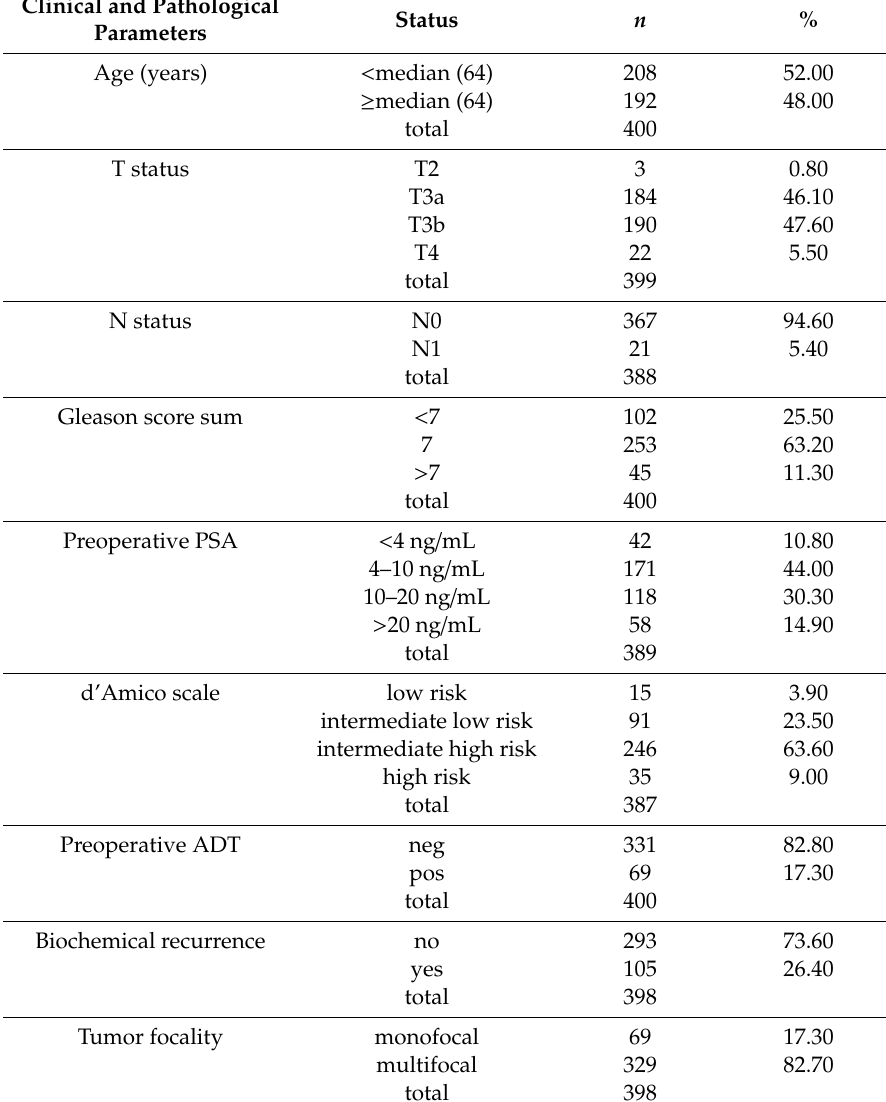
Table 2. Distribution of clinical parameters in the study cohort. neg: negative, pos: positive. Note that not all numbers sum up to 400 due to the missing data. ADT: androgen deprivation therapy. Clinical and